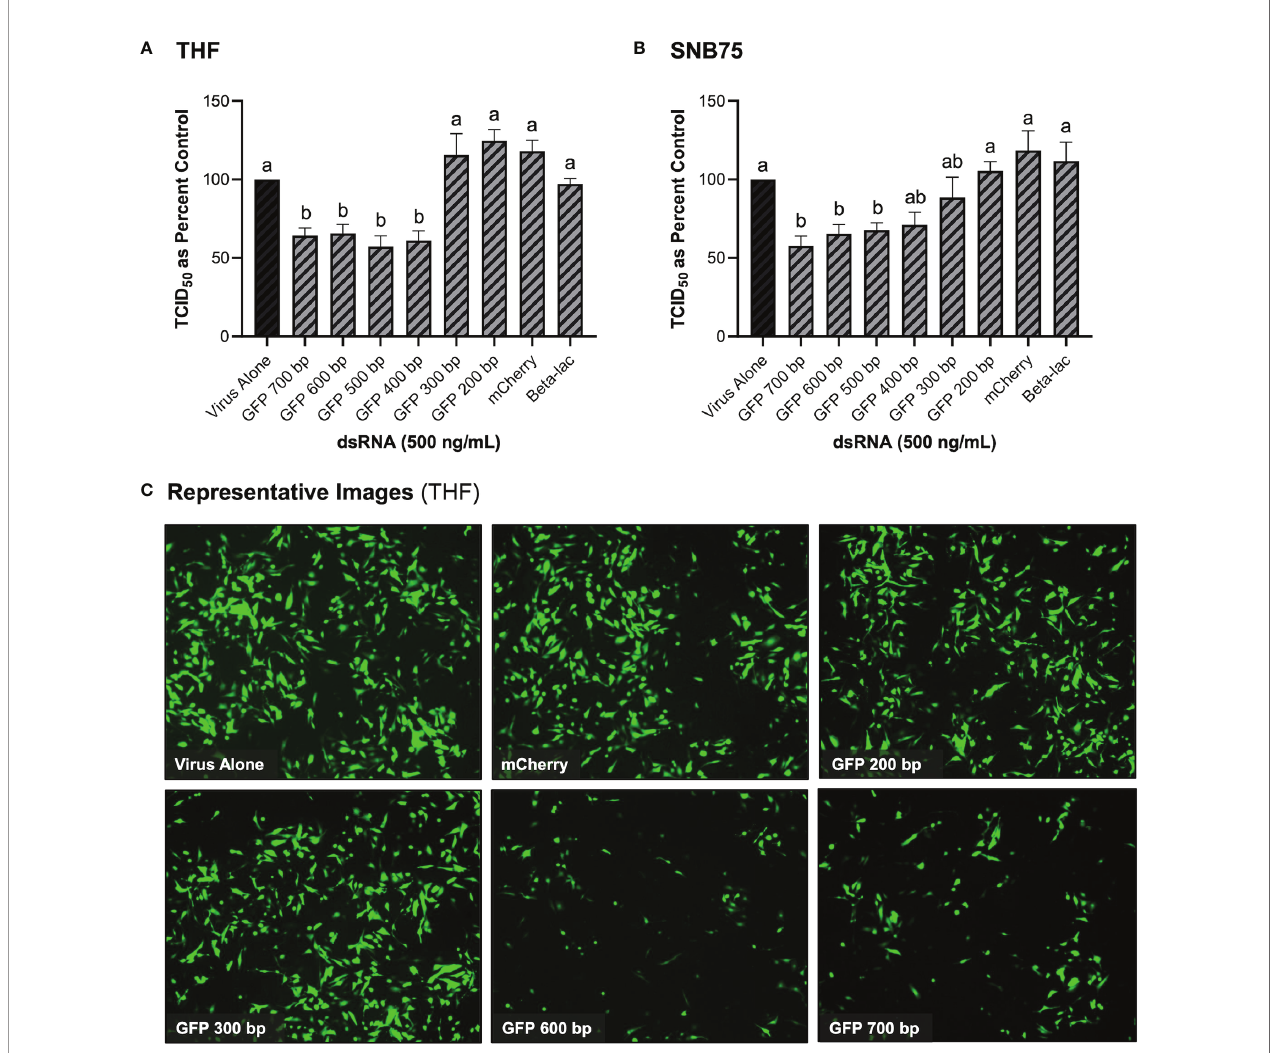
FIGURE 3 | Viral knockdown is observed when pre-soaking cells with sequence-speci fi c long dsRNA and this response is length dependent. THF (A) and SNB75 (B) cells were pre-soaked with either sequence speci fi c (GFP) dsRNA ranging from 200 bp to 700 bp in length, non-sequence speci fi c (mCherry or beta-lac) dsRNA of 700 bp or DPBS as a control for 2h prior to 24h infection with VSV-GFP (MOI = 0.1). Appearance of the THF cells after treatments with dsRNA and VSV-GFP infection as observed under the fl uorescent microscope at 50X magni fi cation (C) . Error bars represent +SEM, and each data point represents the average of 6 independent replicates. A p-value of less than 0.05 was considered to be statistically signi fi cant. Error bars with different letters represent signi fi cantly different